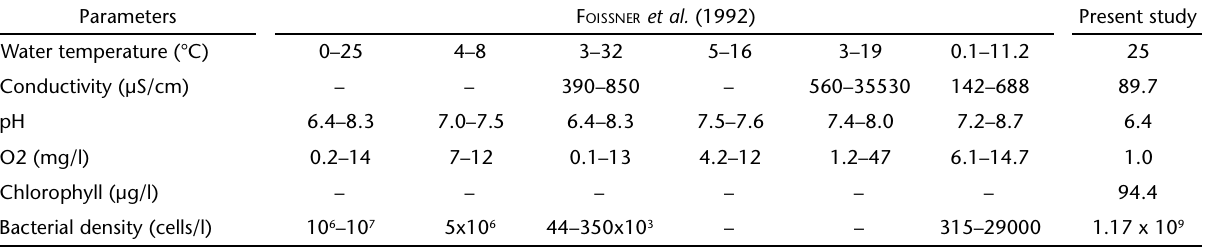
Table II. Autecological data recorded for C. polypinum attached to P. figulina from São Pedro stream, Southeast Brazil (present study) and in previous studies as revised by F OISSNER et al. (1992).